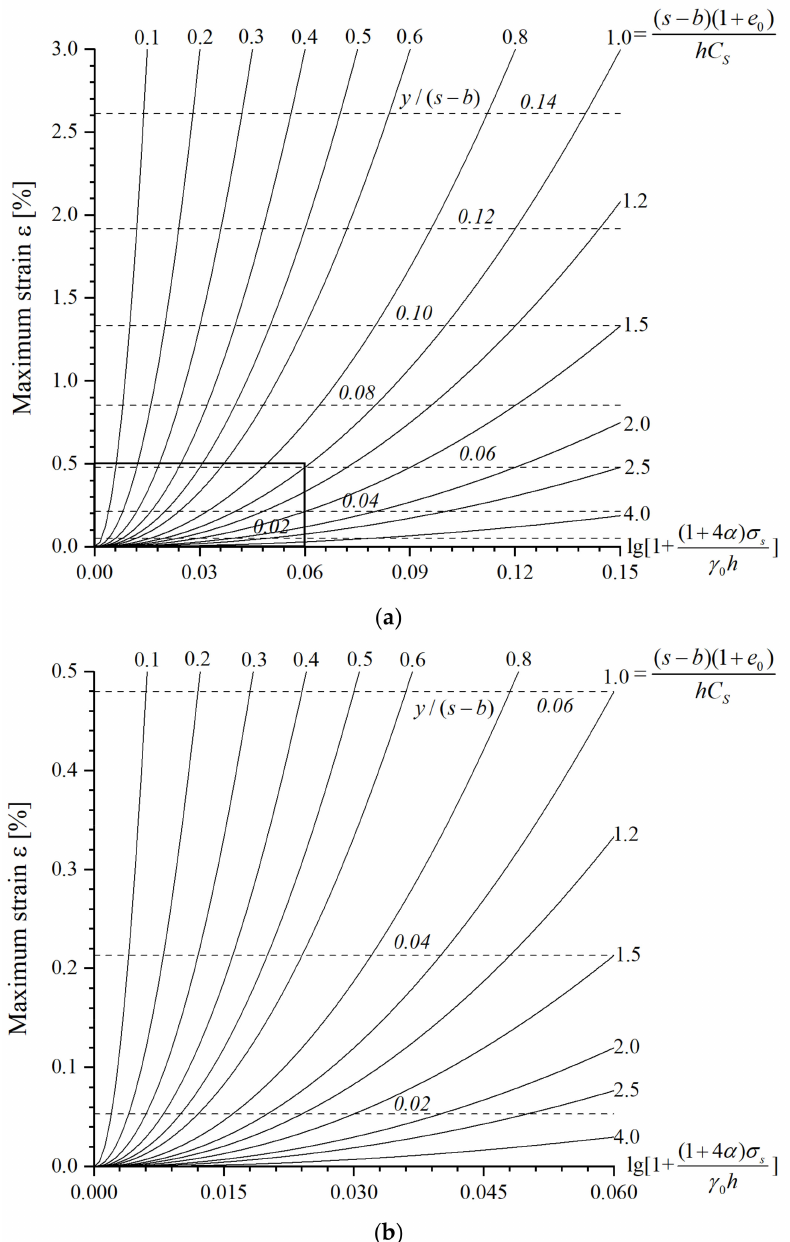
Figure 7. Design charts for a GRPE with over-consolidated soil ( ∆ p ≤ ( p c − p 1 ) ); ( a ) Full-scale chart; ( b ) Enlarged